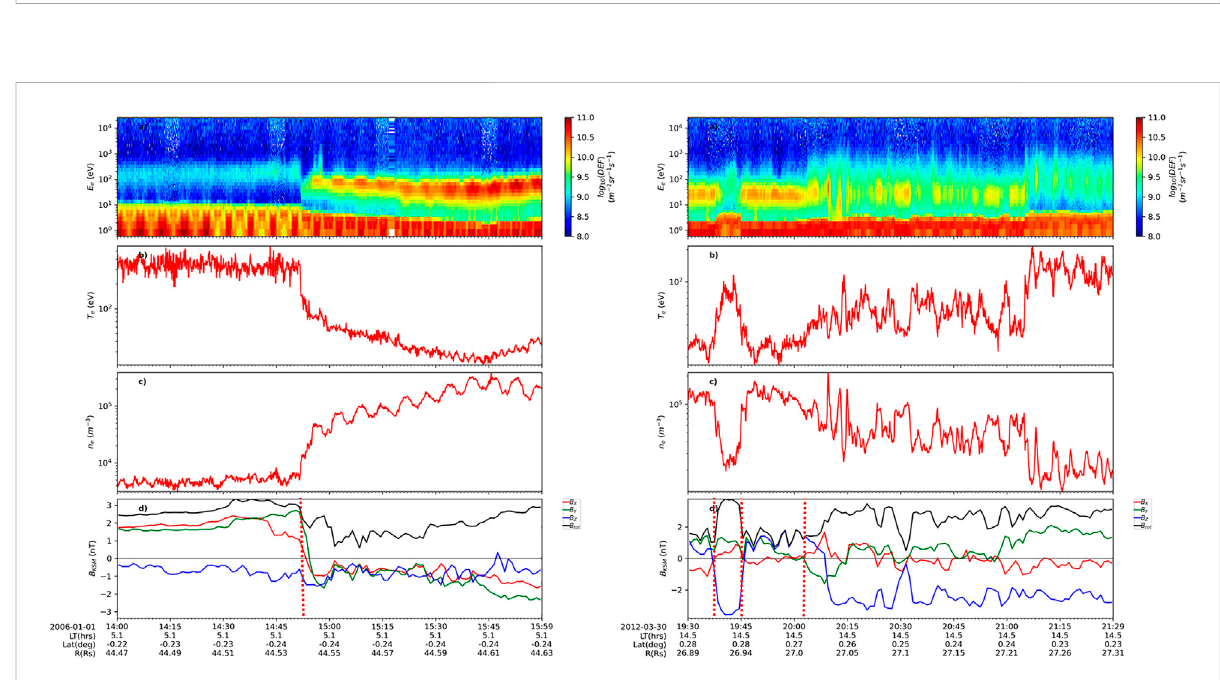
FIGURE 3 Example magnetopause crossings (marked by vertical red dotted lines). The panels are: (A) Electron energy-time spectrogram of differential energy fl ux (DEF) from CAPS/ELS anode 5. (B,C) Electron temperature and number density derived from ELS anode 5. (D) The magnitude and KSM components of the magnetic fi eld, with bow shock crossings marked by vertical blue dotted lines. Spacecraft ephemeris data are given below the x -axis of the